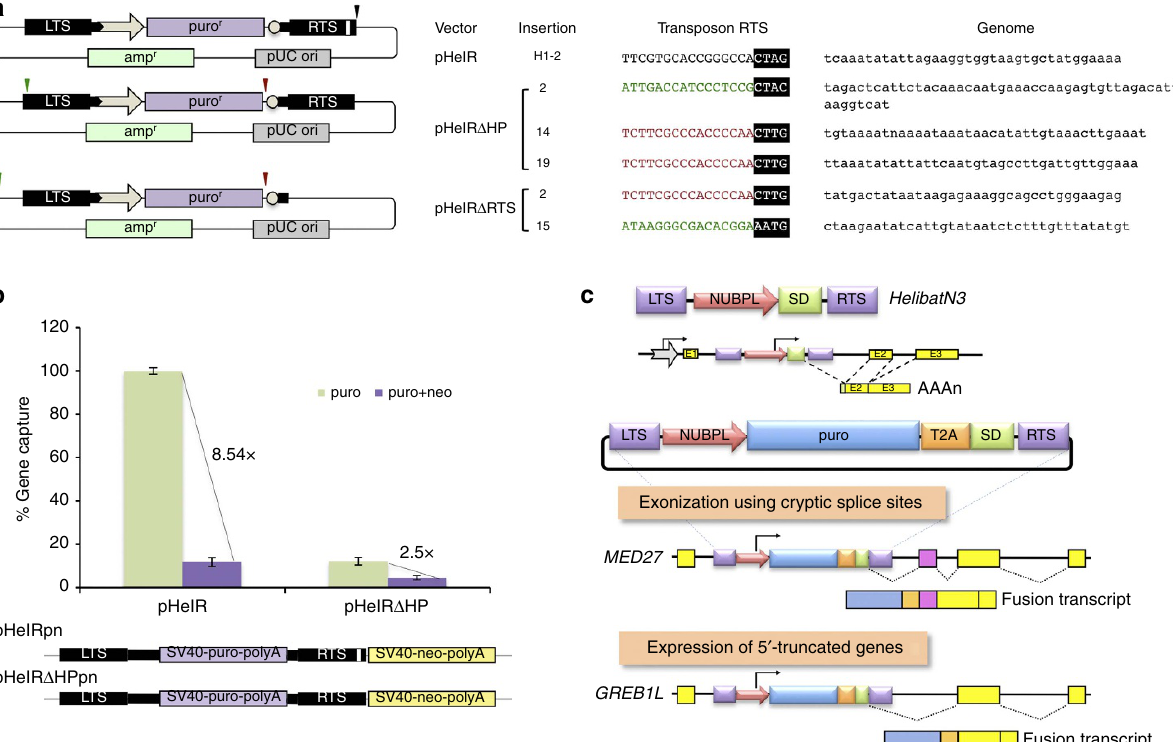
Figure 6 | Mechanism of Helraiser gene capture. ( a ) Identification of novel 3 0 -terminal sequences generated by pHelR D RTS and pHelR D HP transposition. Relative positions of canonical and de novo 3 0 -ends generated in pHelR, pHelR D HP and pHelR D RTS transposition are indicated by black (canonical RTS), red (truncations) and green (read-through events) arrows. Sequences representing new transposon 3 0 -terminus-to-genome junctions are shown on the right. ( b ) Gene capture efficiency of HelR and HelR D HP transposons as measured by transduction of a neomycin resistance cassette. Data are represented as mean ± s.e.m., n ¼ 3 biological replicates. ( c ) De novo formation of novel transcripts by HelibatN3 transposition. On the top, the HelibatN3 transposon containing a fragment of the NUBPL gene containing the promoter and a small piece of the coding region followed by a splice donor (SD) between the left and right terminal sequences (LTS and RTS) of the transposon is depicted. In the middle, a HelibatN3 transposon tagged with a puromycin resistance selectable marker is shown. The T2A self-cleaving peptide sequence allows processing of the primary fusion protein to allow more reliable puro expression. On the bottom, two examples show exonization of noncoding RNA and truncation of mRNAs by imposed splicing. MED27 , mediator complex subunit 27 gene; GREB1L, growth regulation by oestrogen in breast cancer-like